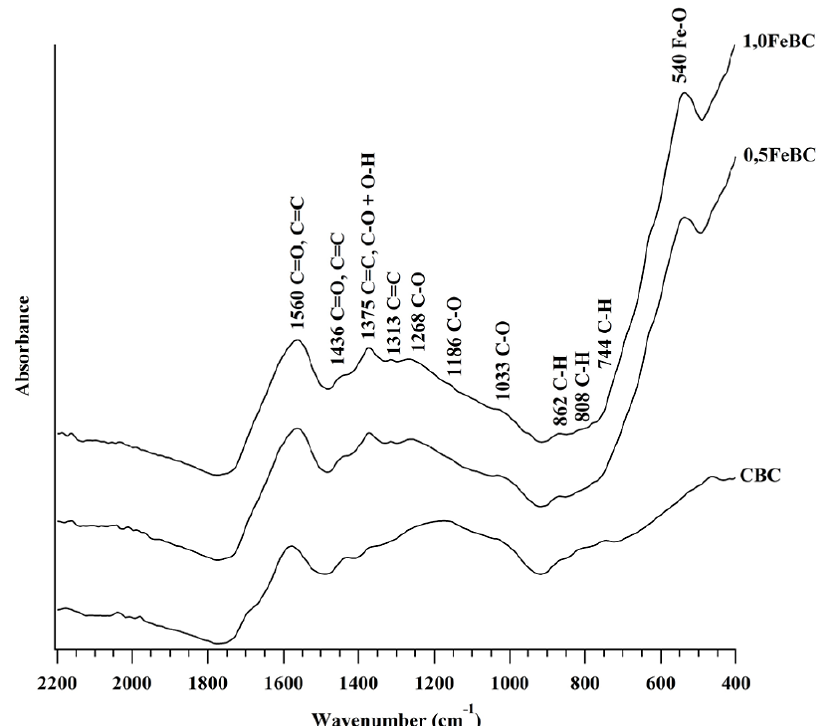
Figure 1. Fourier transform infrared spectra of three biochar samples. (a) range 4000 to 2200 cm -1 , and (b) range 2200 to 400 cm -1